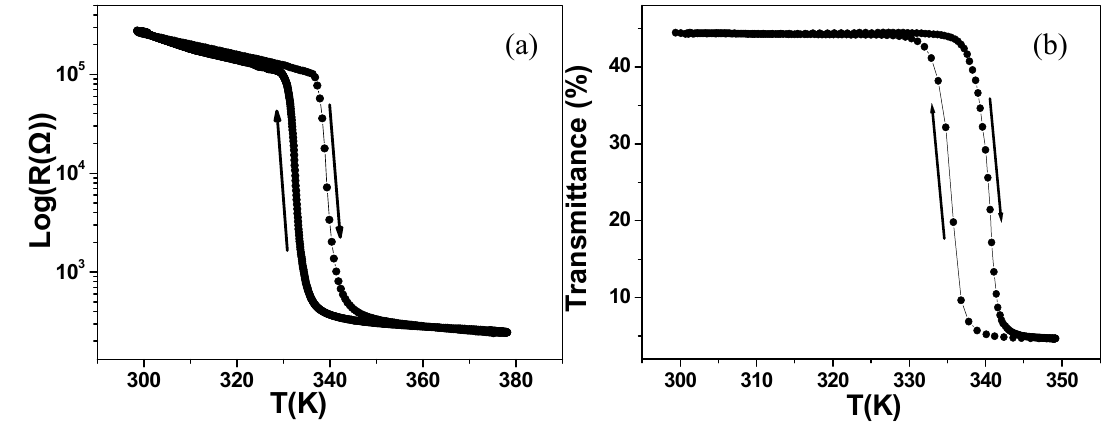
Figure 1. ( a ) Temperature dependence of the electrical resistance of a VO 2 thin film on glass at T = 300–380 K, as has been experimentally measured; ( b ) temperature dependence of the optical transmittance of a VO 2 thin film on glass at λ = 1550 nm for T = 300–350 Κ , as has been experimentally measured.